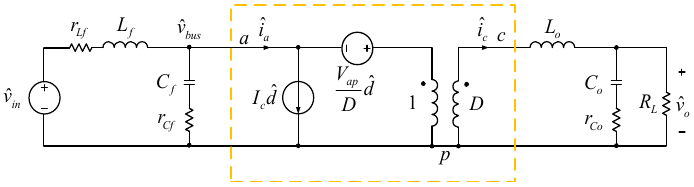
Figure 5. Small signal model of an open-loop LLC series Buck converter.